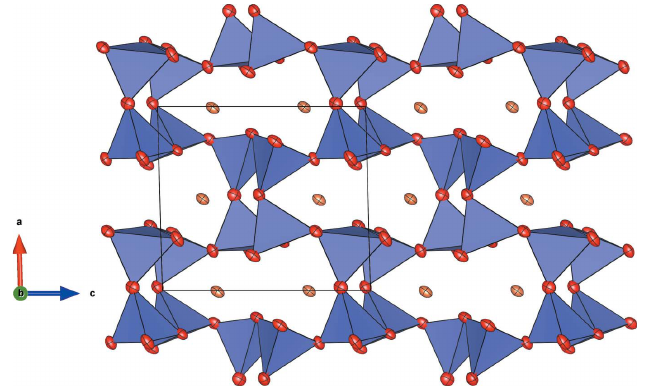
Figure 5 Strongly folded tetrahedral layer with four- and eight-membered rings in a projection along [010]. Displacement ellipsoids are drawn at the 70% probability level.